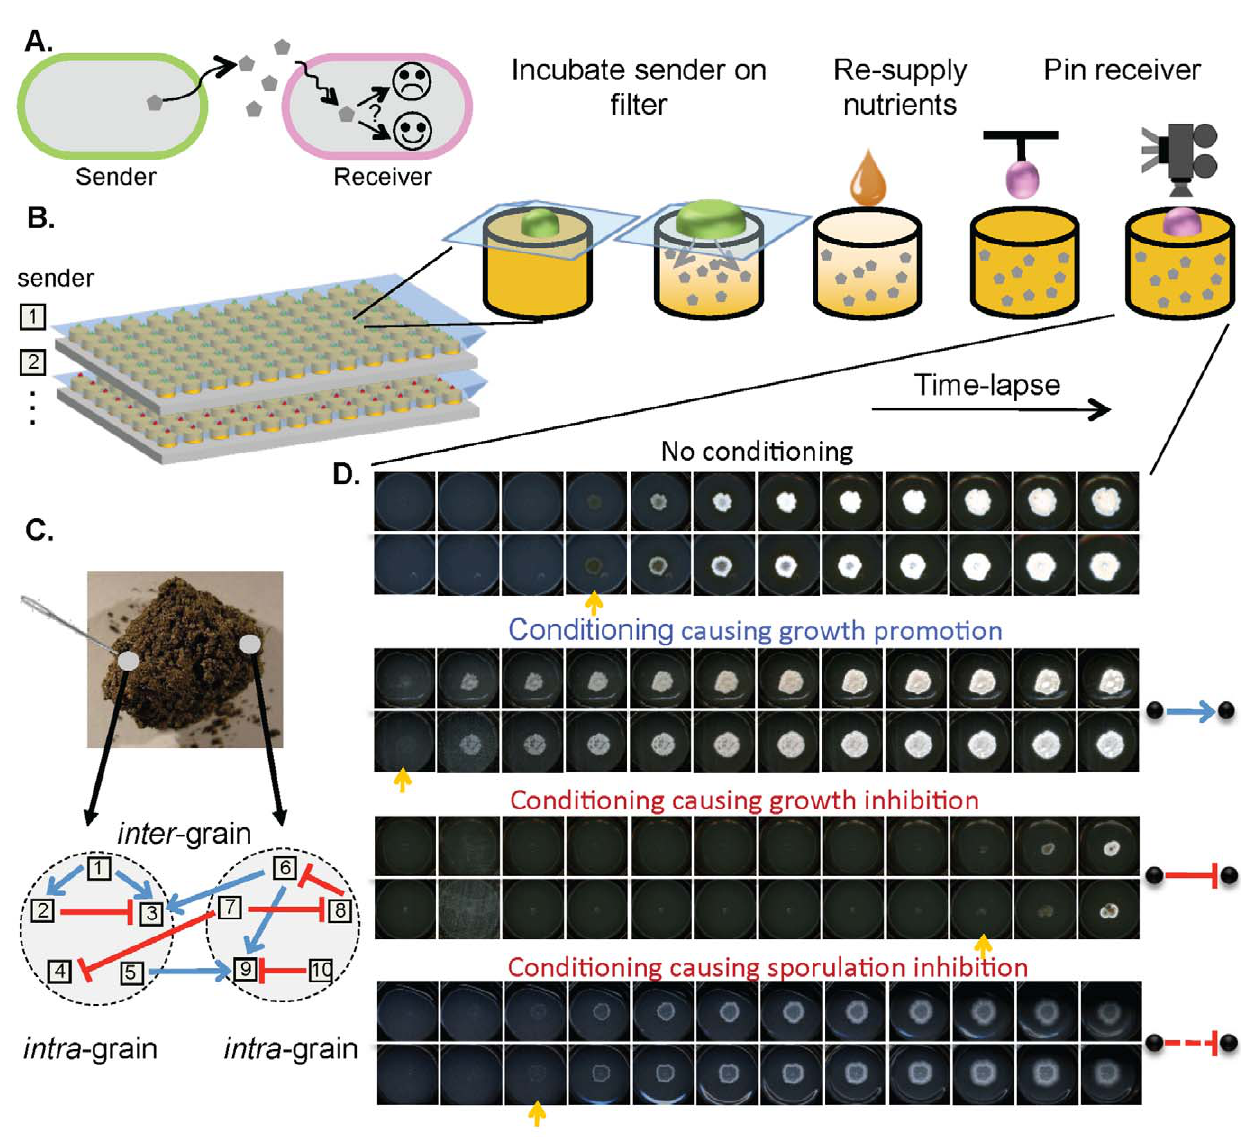
Figure 1. Platform for high-throughput measurement of pairwise interactions. (A) A directional pairwise interaction measures how the products of a sender strain affect the morphological colony development of a receiver. (B) A fine-pored filter is placed on an agar surface, a lawn of the sender is grown on top, and the filter is removed, leaving behind sterile agar that has been altered ( conditioned ) by the sender strain. The conditioned agar is then resupplied with concentrated liquid nutrients to compensate for the nutrients consumed by the donor. A receiver strain is pinned (point-inoculated) onto agar and imaged frequently, which allows us to see the developmental phenotype of the receiver. (C) Grains were sampled with a needle tip from soil cores, and Streptomyces strains isolated. (D) By comparing colony growth of the receiver strain on conditioned and non-conditioned agar, we can identify interactions between strains. Shown is the colony development of a receiver in two replicas on non- conditioned and three conditioned media (on a subset of time points). The colony appearance time is marked by orange arrow. We observed partial or complete inhibitions of growth, faster colony appearance, inhibition of aerial mycelium formation, as well as (not shown) changes in colony morphology and sporulation enhancements. We have developed a high-throughput implementation of this technique using 96-well agar plates, robotic inoculation of the sender, nutrient resupply and pinning, an array of 30 modified optical scanners, and automated data acquisition and image